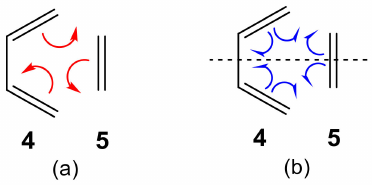
Scheme 2. Changes in electron density in the DA reaction between butadiene 4 and ethylene 5 :